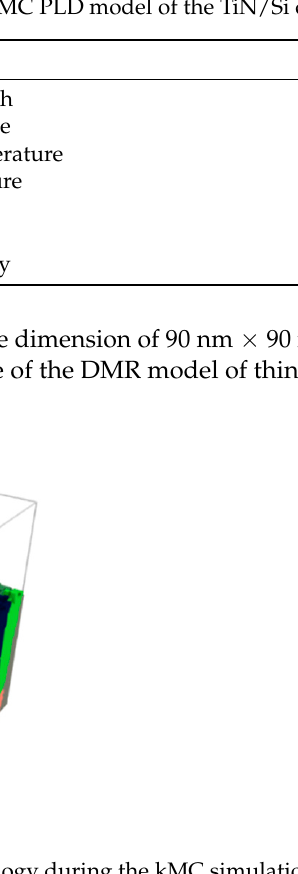
Table 1 . Parameters used in the kMC PLD model of the TiN/Si deposition.